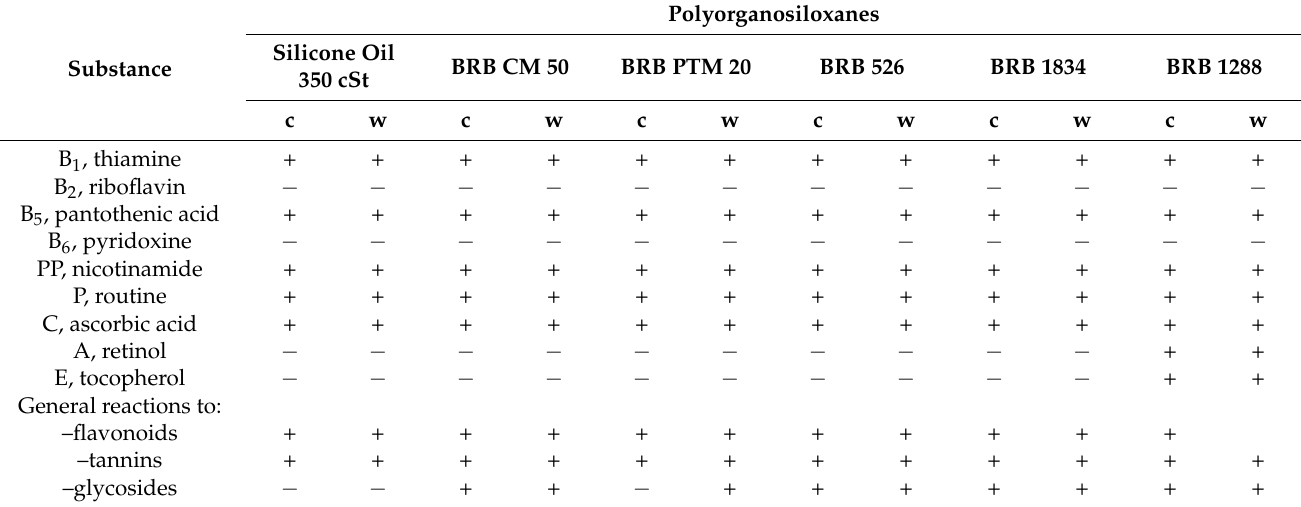
Table 3. Qualitative determination of biologically active substances in silicone extracts of calendula (c) and wormwood (w). (+ presence, − absence).